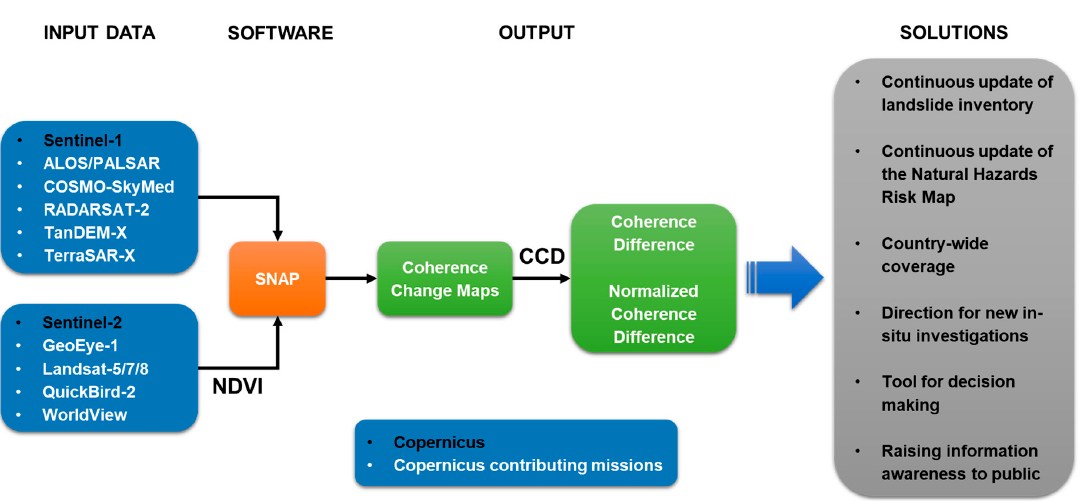
Figure 26. The Coherent Change Detection (CCD) methodology and the solutions that it can offer.